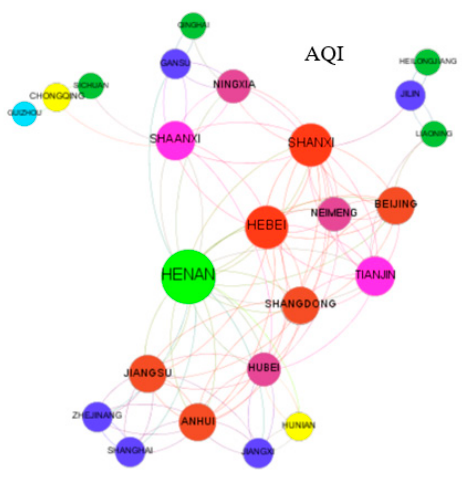
Figure 3. AQI spatial correlation network in 2018.